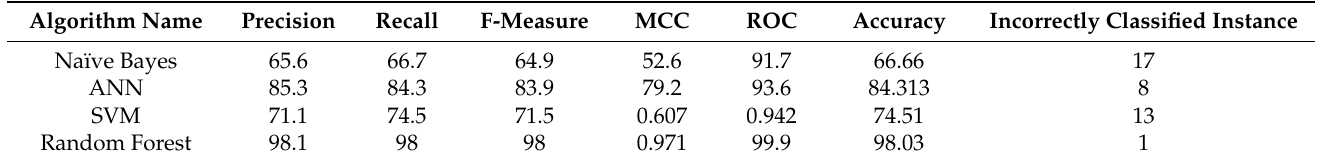
Table 3. Comparison among classification algorithms during the training phase to predict the total infected cases.